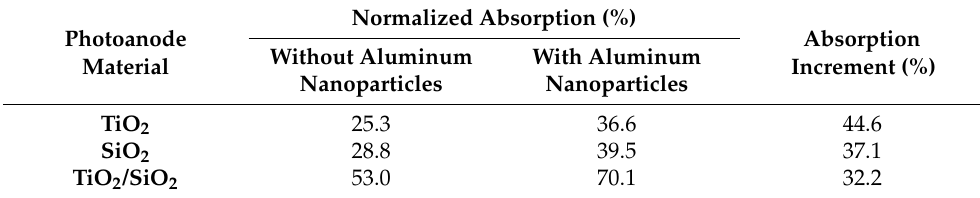
Table 2. Normalized absorption values of TiO 2 , SiO 2 and TiO 2 /SiO 2 with and without aluminum nanoparticles.